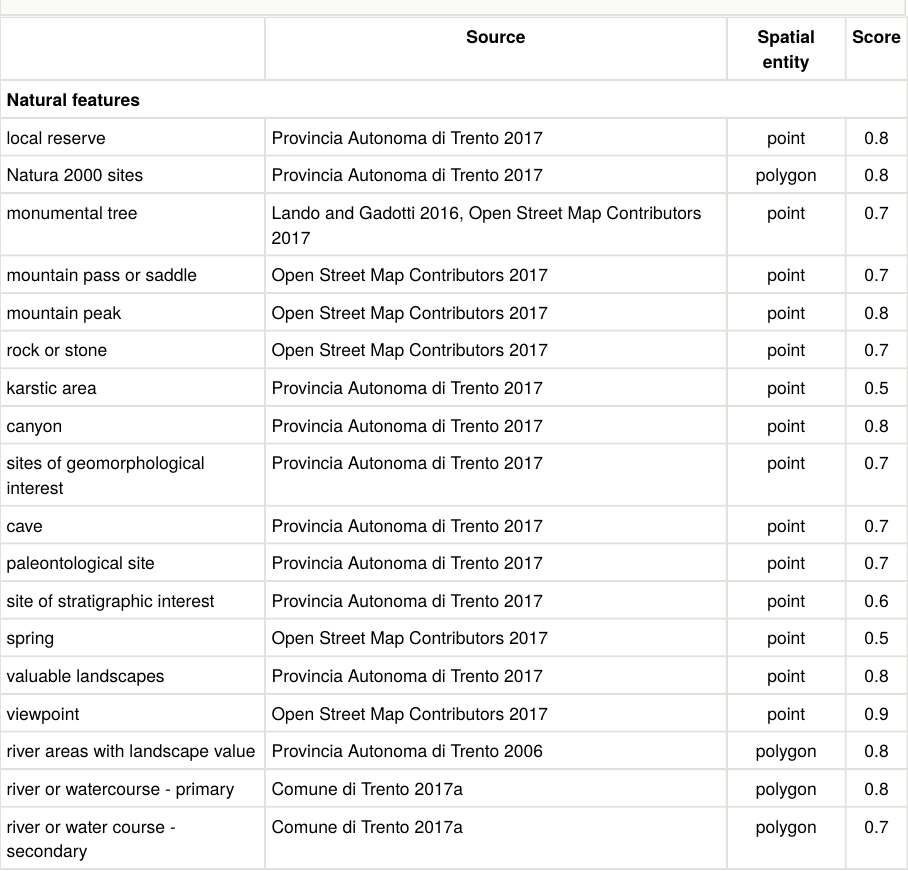
Table 3. Input data of the ESTIMAP-recreation model divided by model component and respective scores assigned by the